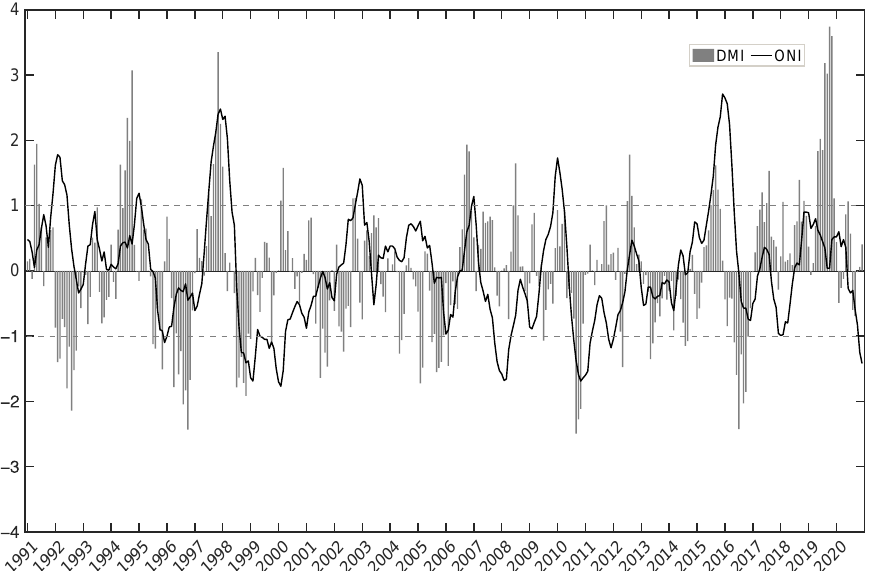
Figure 1. Dipole Mode Index (DMI) time series (gray bar) and Niño 3.4 index (ONI) time series (black line).